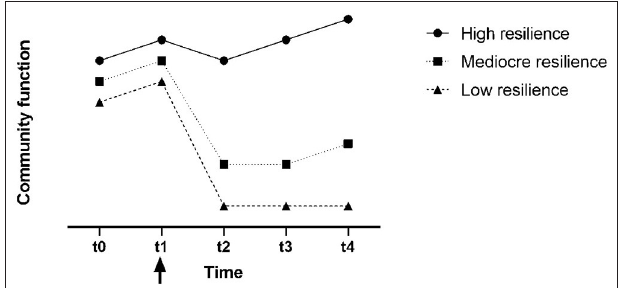
FIGURE 1 | A hypothetical trajectory of community function based on their level of resilience. Arrow indicates the onset of crisis/disaster situation [Modified from Zhang (8) and Mayunga